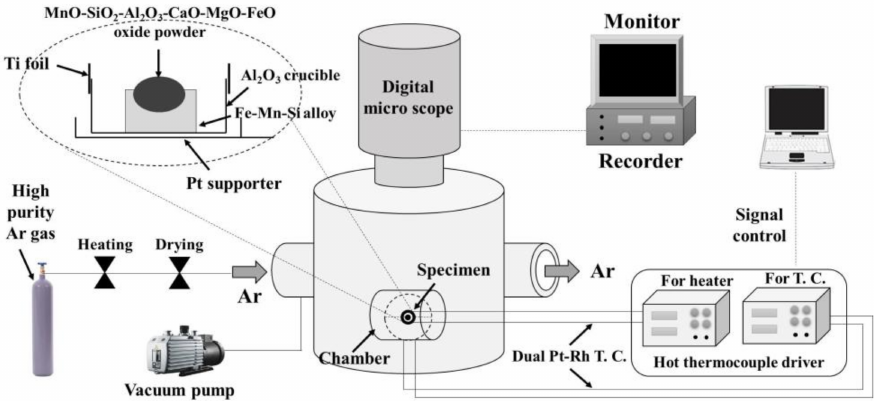
Figure 1. Experimental setup for the premelting of the oxide contained in the alloy cake by a confocal scanning laser microscope